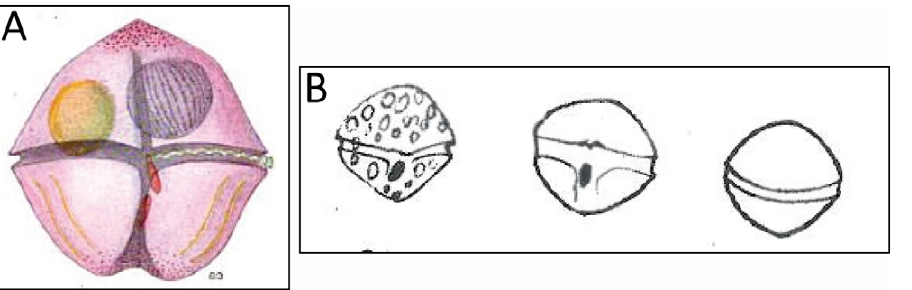
Figure 3. Drawings of Gymnodinium that accompany original descriptions. A) Drawing of Gymnodinium sulcatum Kofoid and Swezy 1921 [19]. B) Drawing of Gymnodinium amphiconicoides Schiller 1957 [15]. Items out of copyright. Note the difference in detail between the two drawings.